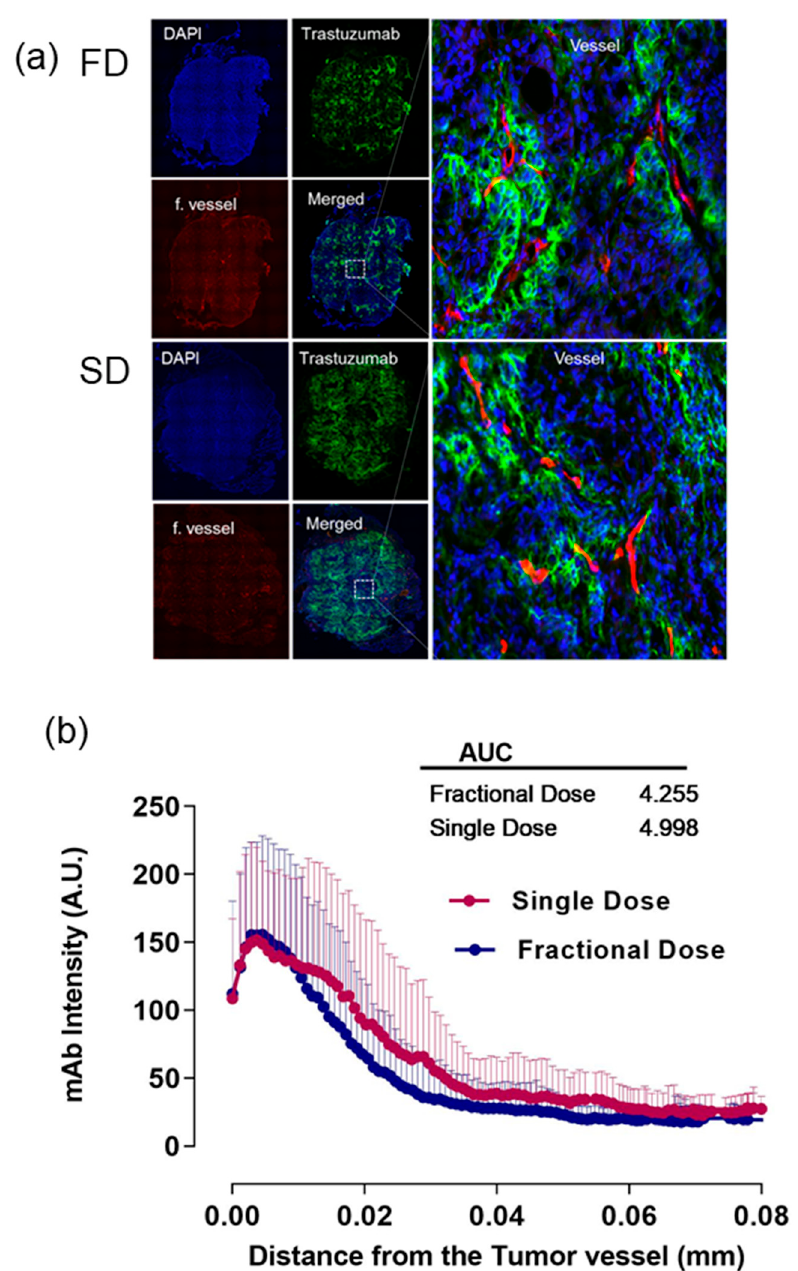
Figure 2. Representative images of SD and FD. ( a ) DAPI (4 ′ ,6-diamidino-2-phenylindole) in blue, TRZ (trastuzumab) intensity in green, functional vessel in red, merged images, and zoomed merged area near vessel. ( b ) Histogram plot shows line profiling comprising mean and standard deviation as error bars (above) of SD (single dose) and FD (fractional dose) with respective AUC values.